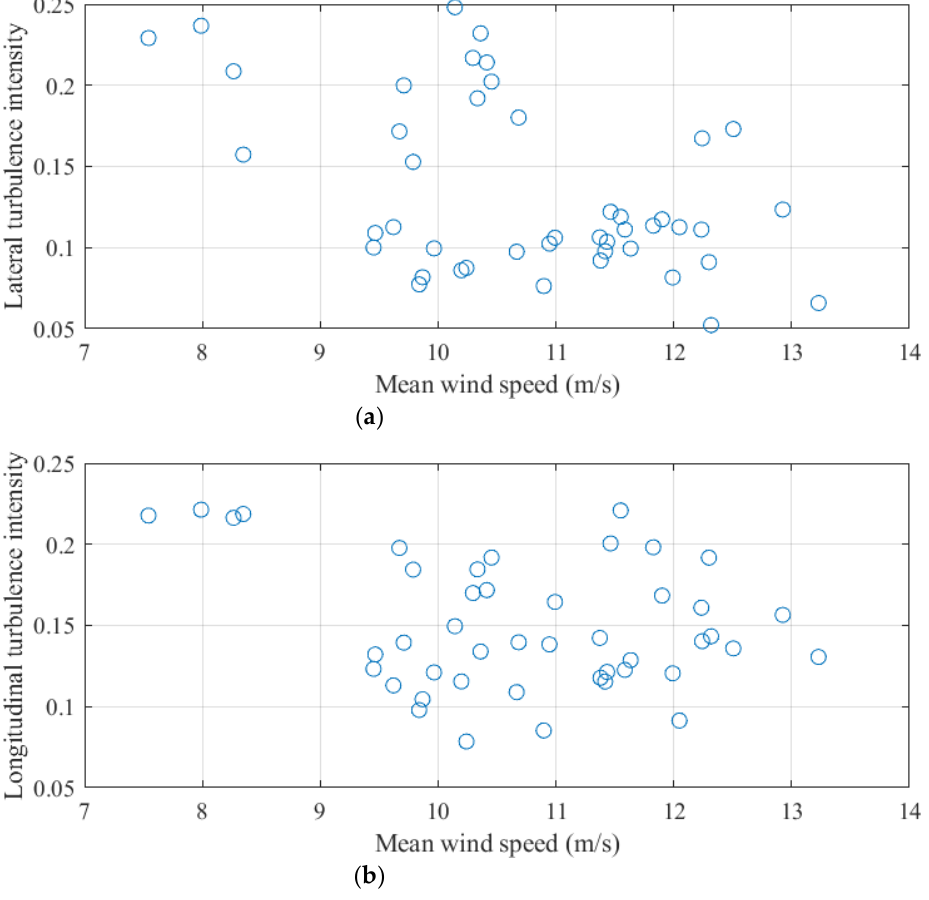
Figure 6. Relationship between turbulence intensity and mean wind speed: ( a ) longitudinal direction; ( b ) lateral direction.